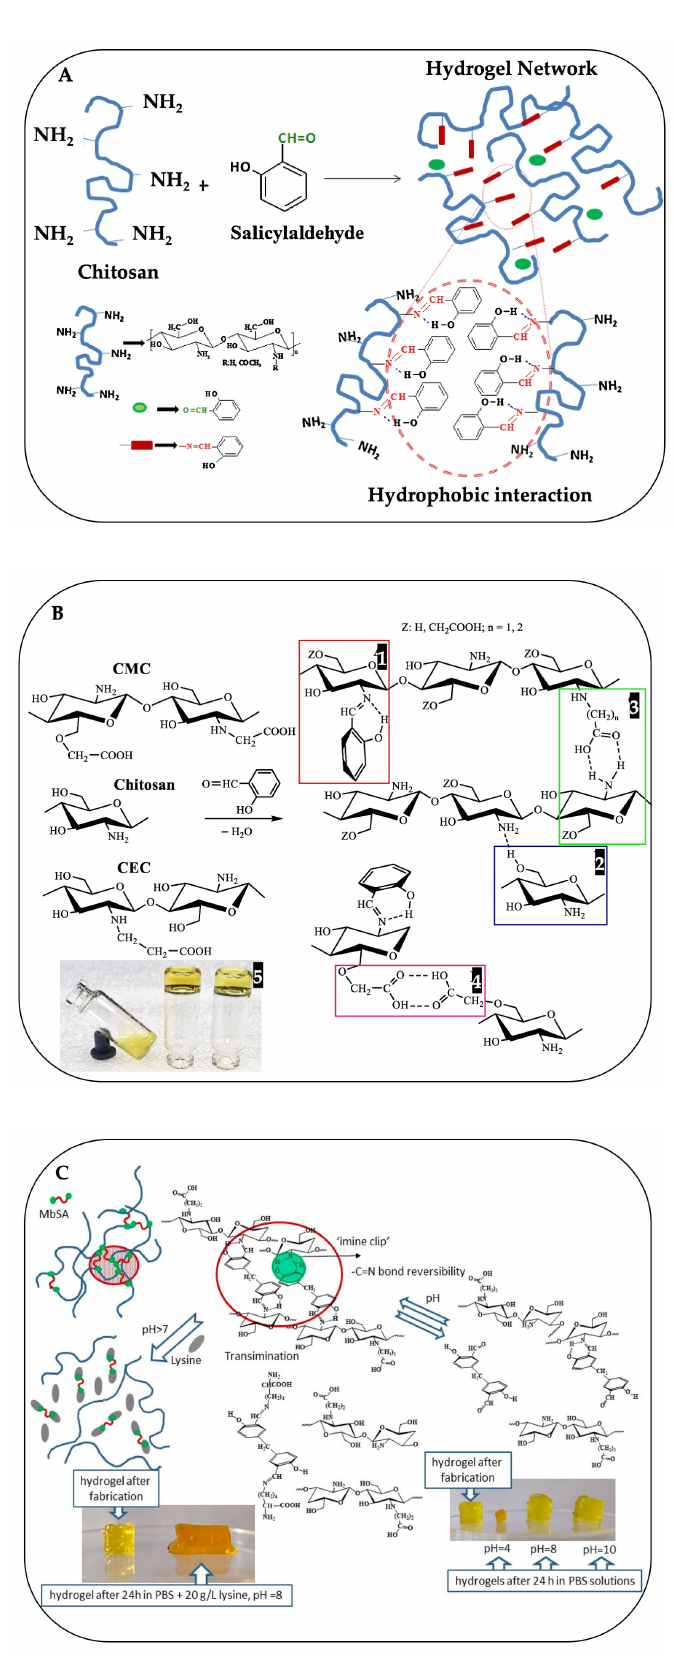
Figure 2. Synthesis of the salicyl-imine-chitosan hydrogels ( A ) [reprinted with permission from ref. [106] Copyright © 2017, Elsevier], chemical structures of chitosan, and its carboxyalkyl derivatives (car- boxymethylchitosan; CMC and carboxyethylchitosan; CEC), with a hypothetical scheme of